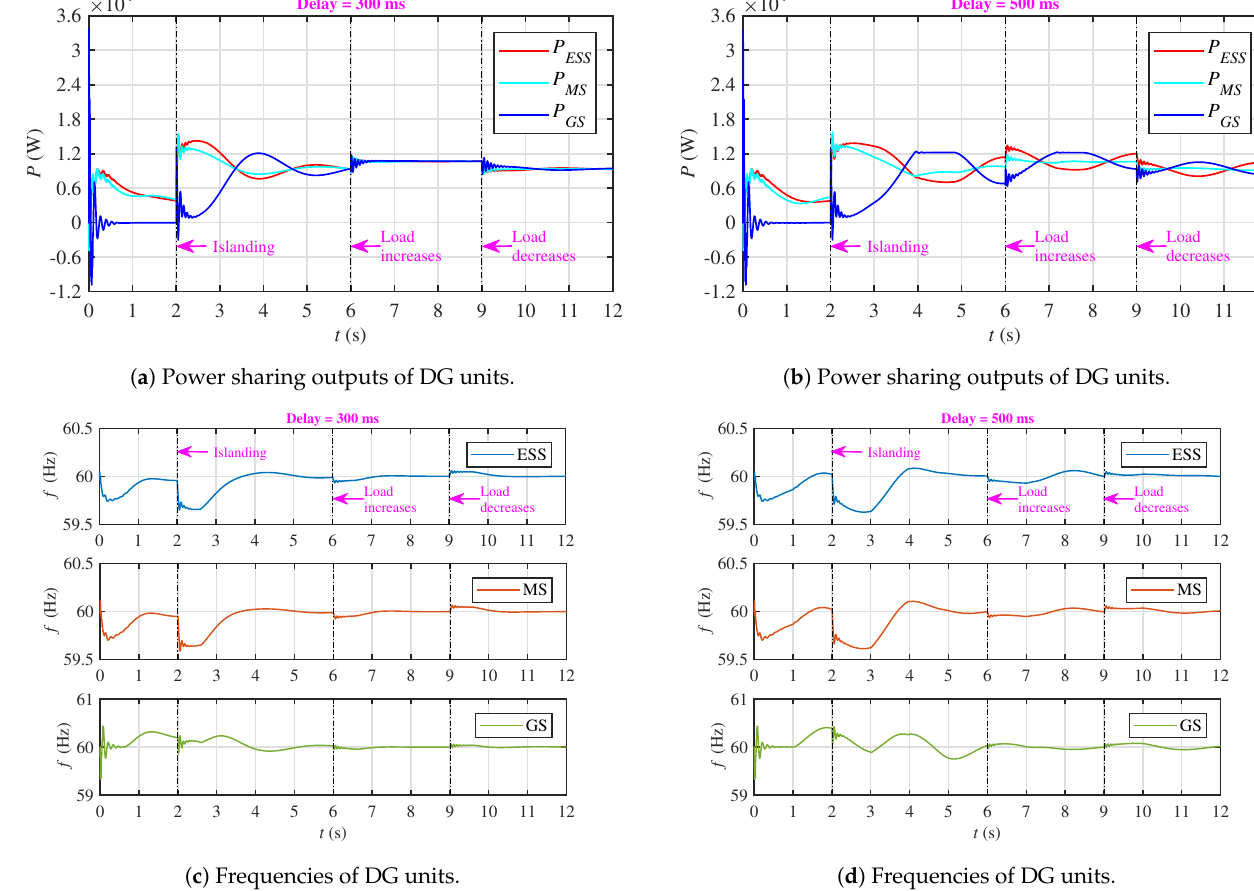
Figure 13. Power sharing outputs and frequency regulation of DG units under different communication latencies using the existing protocol, as reported in